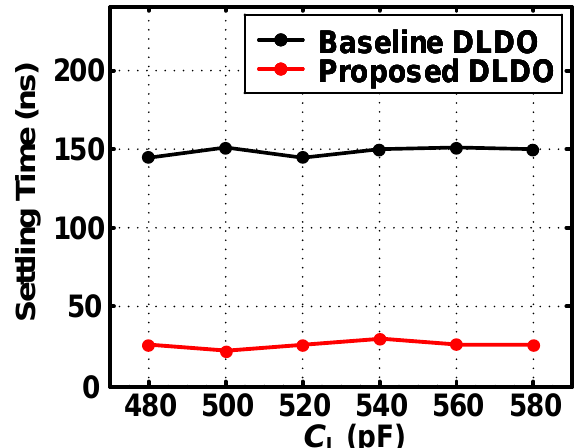
Figure 9. The settling time with load capacitance change.